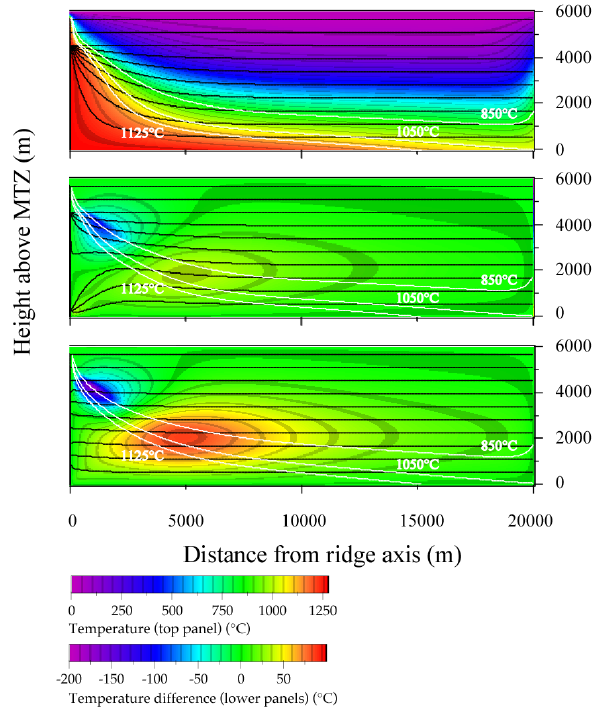
Figure 3: Temperature and stream function obtained for the G (top), M (middle) and S (bottom) crustal accretion modes. To increase the readability of the figure the temperature field obtained for the G structure has been represented in the top panel. Values of temperature correspond to the top color scale. For the M and S structures (medium and lower panels, the temperatures are represented as difference with the gabbro glacier (G) structure above. The direction of velocity is directly given by the stream- function contours (black lines). White lines display the locations of the 1125, 1050 and 850°C isotherms that will be used for the computation of the average cooling rates (see text and Fig. 6). The results have been obtained with an intermediate hydrothermal cracking temperature T crac = 700°C and a viscosity contrast of two orders of magnitudes.